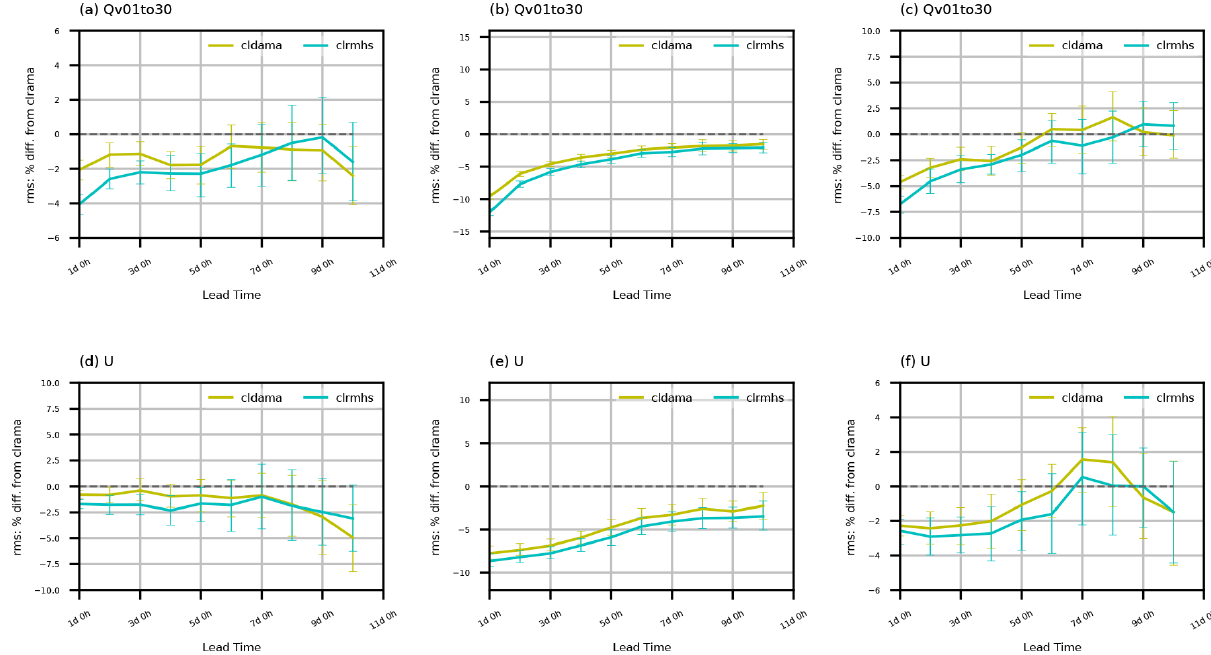
Figure 9. Similar to Fig. 8 but for water vapor mixing ratio below model level 30 and zonal wind over the three regions (30–90 ◦ N, 30 ◦ S– 30 ◦ N, and 30–90 ◦